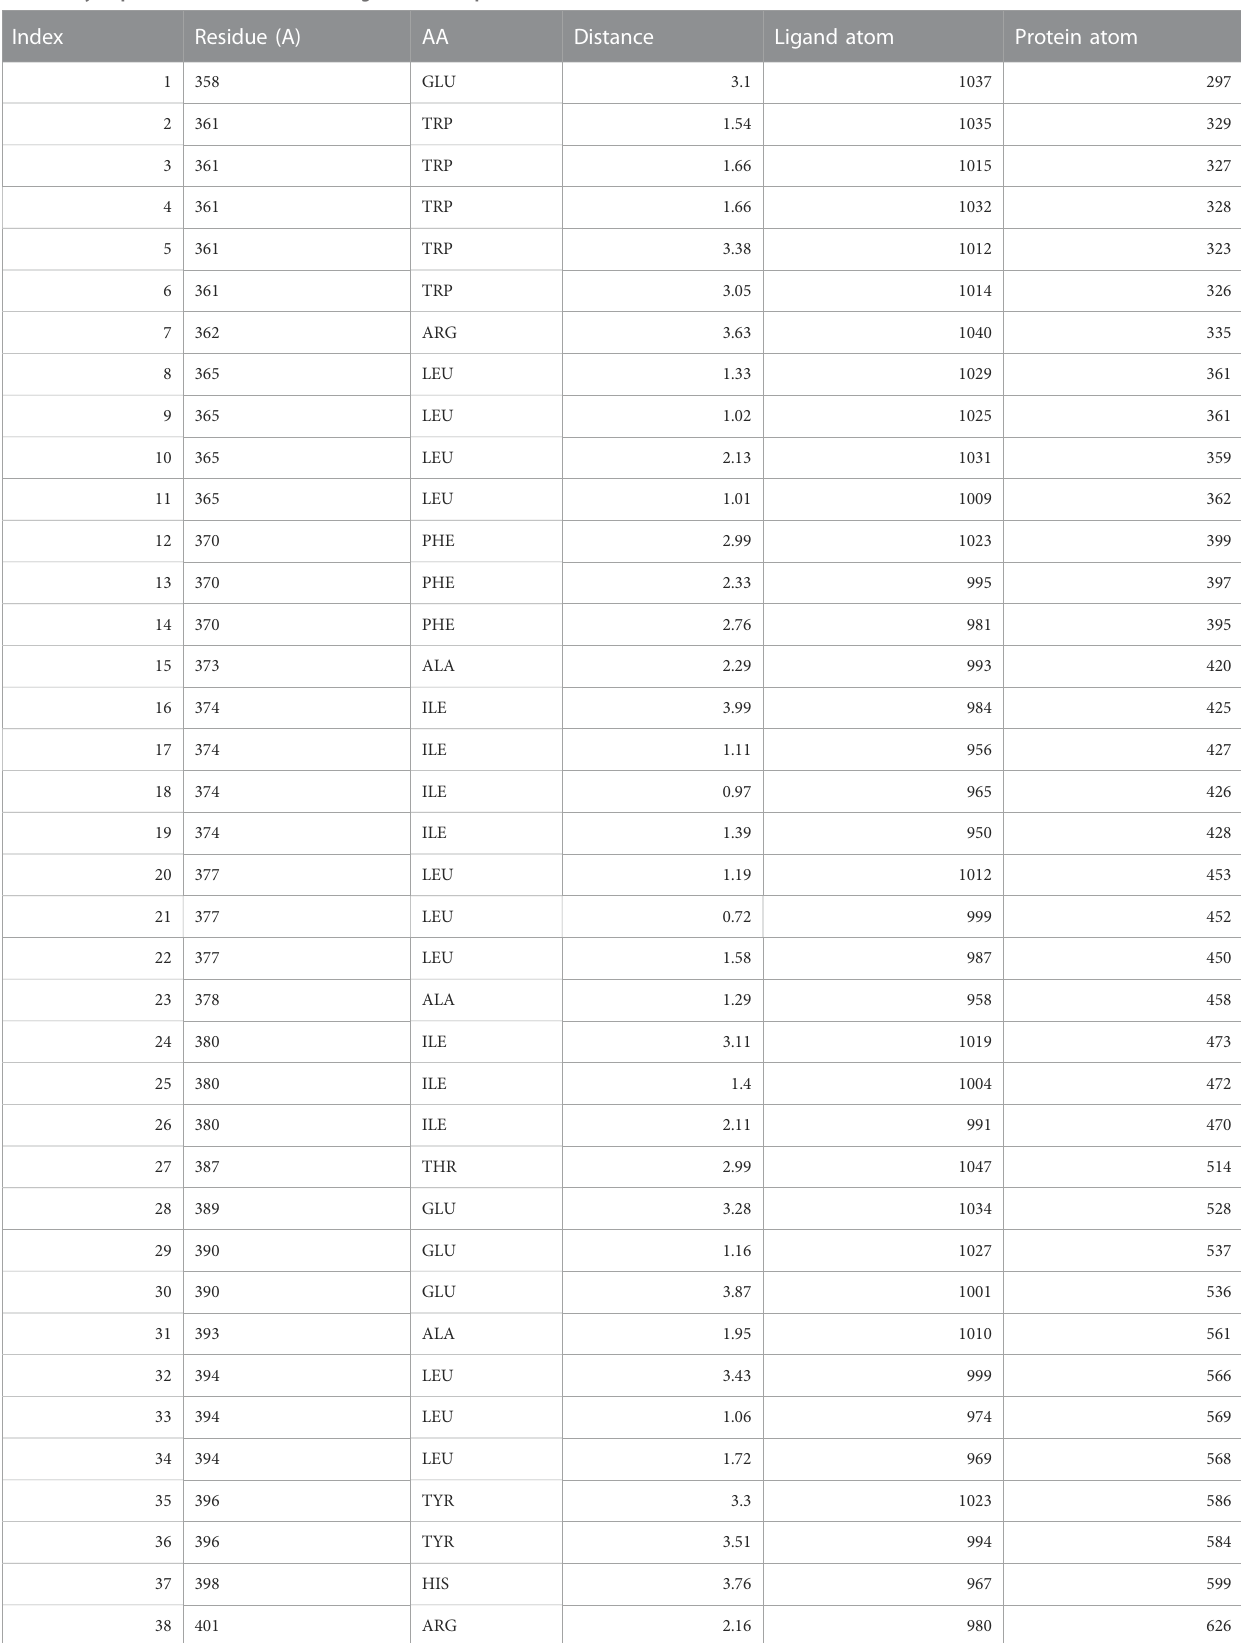
TABLE 5 Hydrophobic Interactions between ligand and receptor atoms. Index Residue (A) AA Distance Ligand atom Protein